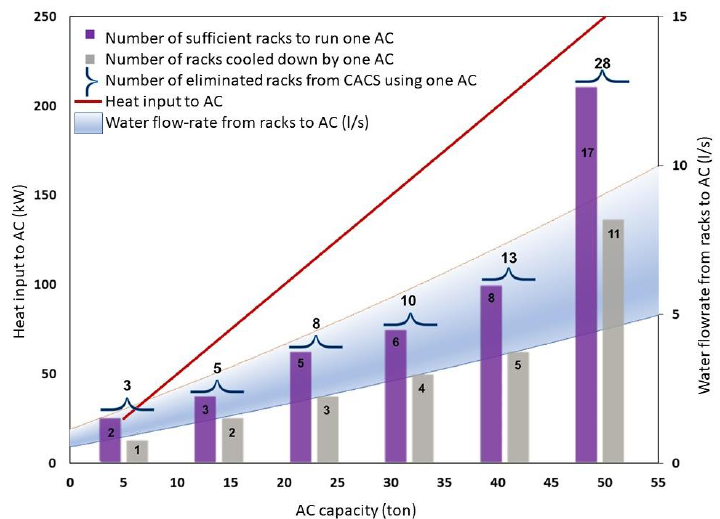
Figure 2. Heat dissipation by server racks and cooling process by AC chillers.